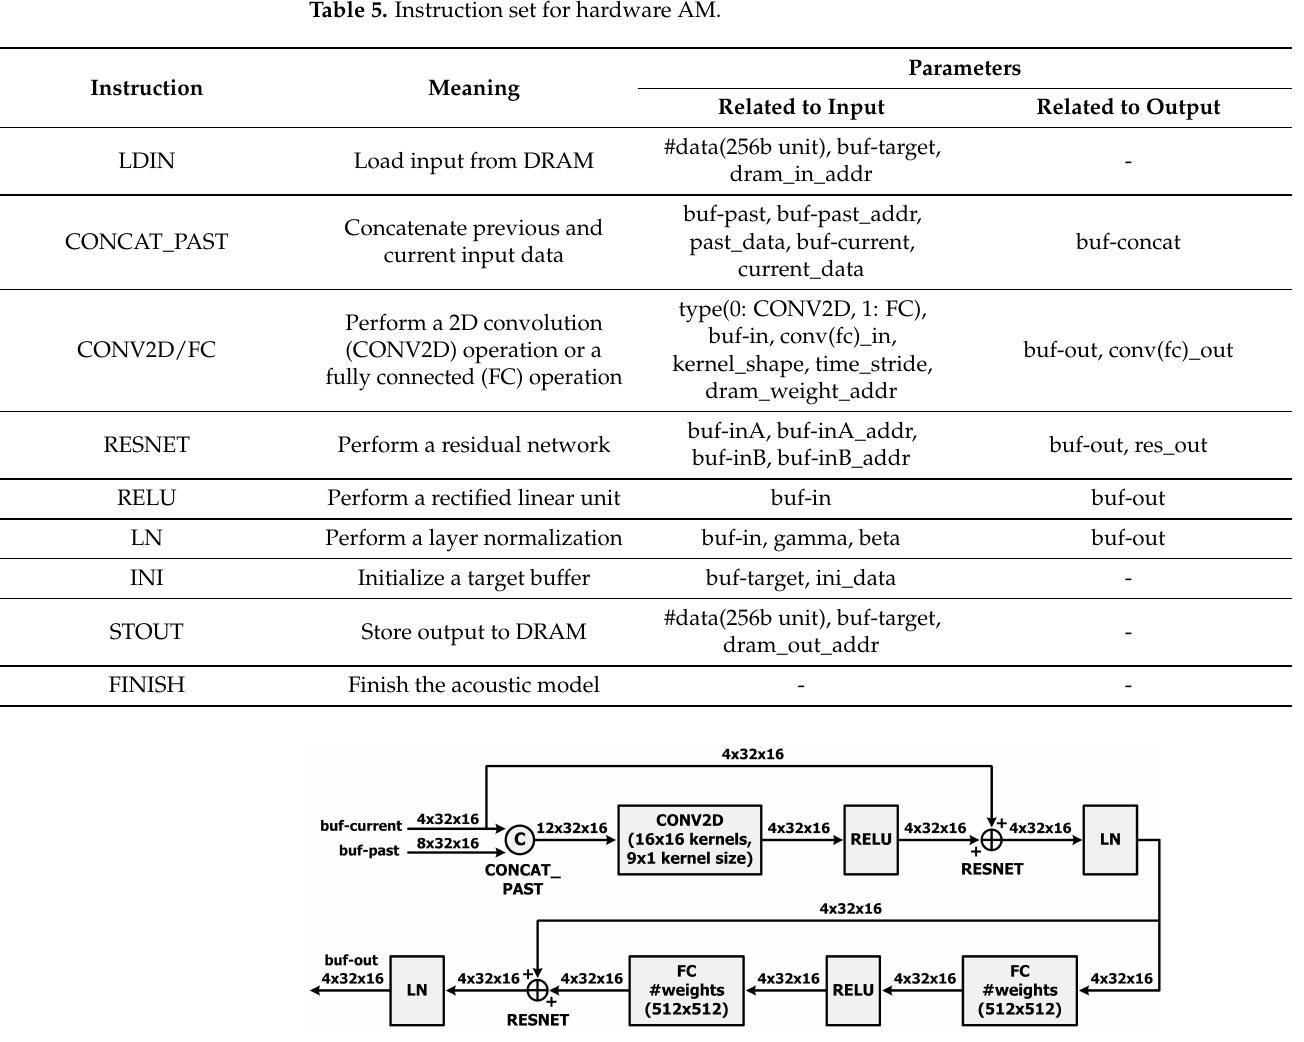
Figure 2. A single TDS operation of the first TDS block in Table